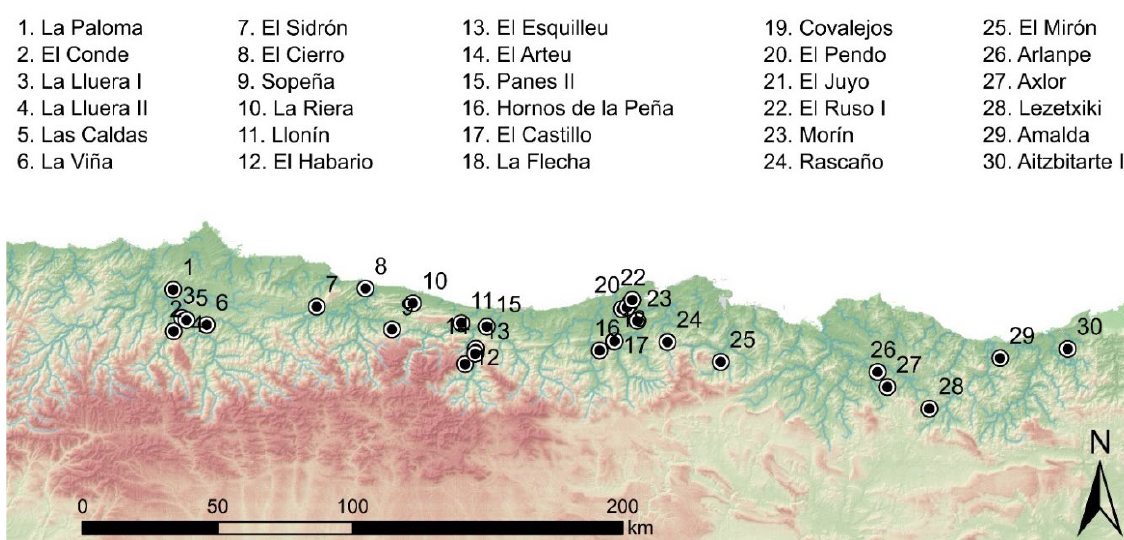
Figure 2. Archaeological sites included in this research.